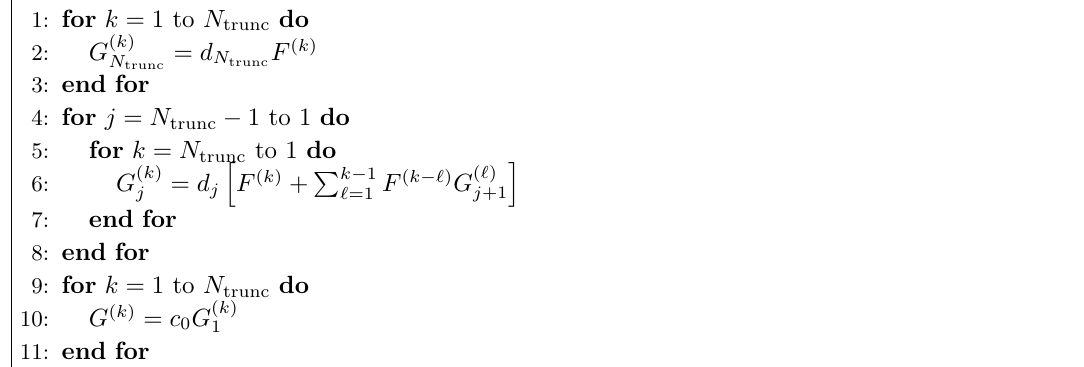
Algorithm 3. Recursion algorithm for the perturbative expansion of a matrix function f ( F ). The maximum order N trunc of expansion is (cid:12)xed. G ( k ) is the perturbative coe(cid:14)cient [ f ( F )] ( k )